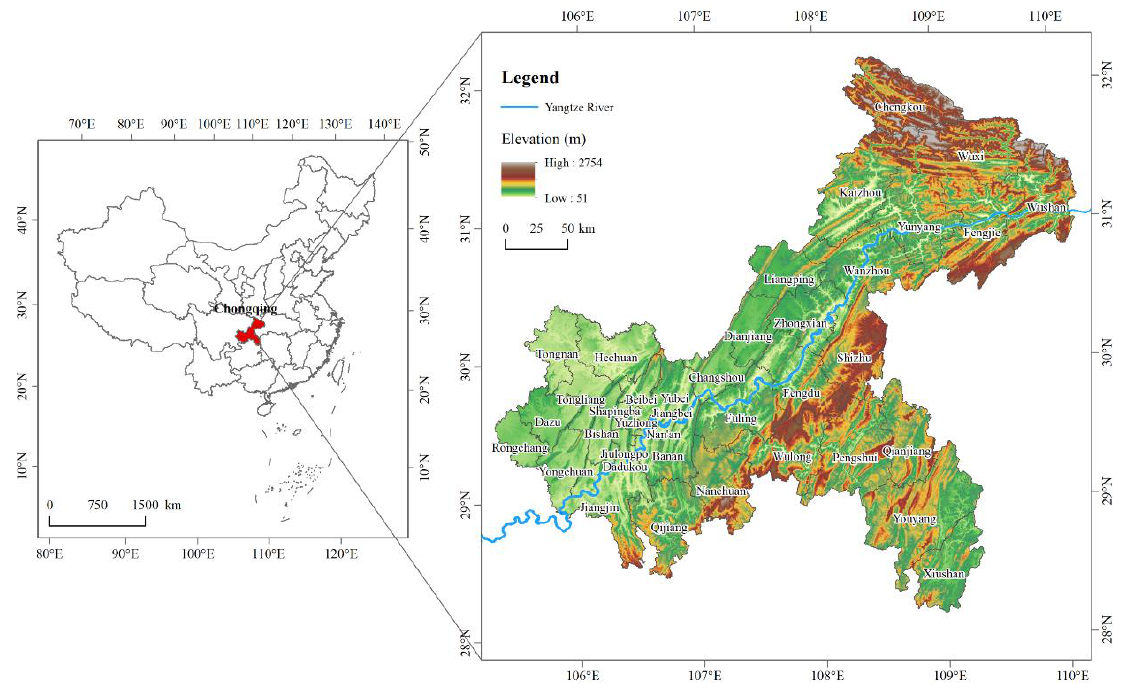
Figure 1. Location map of the study area.